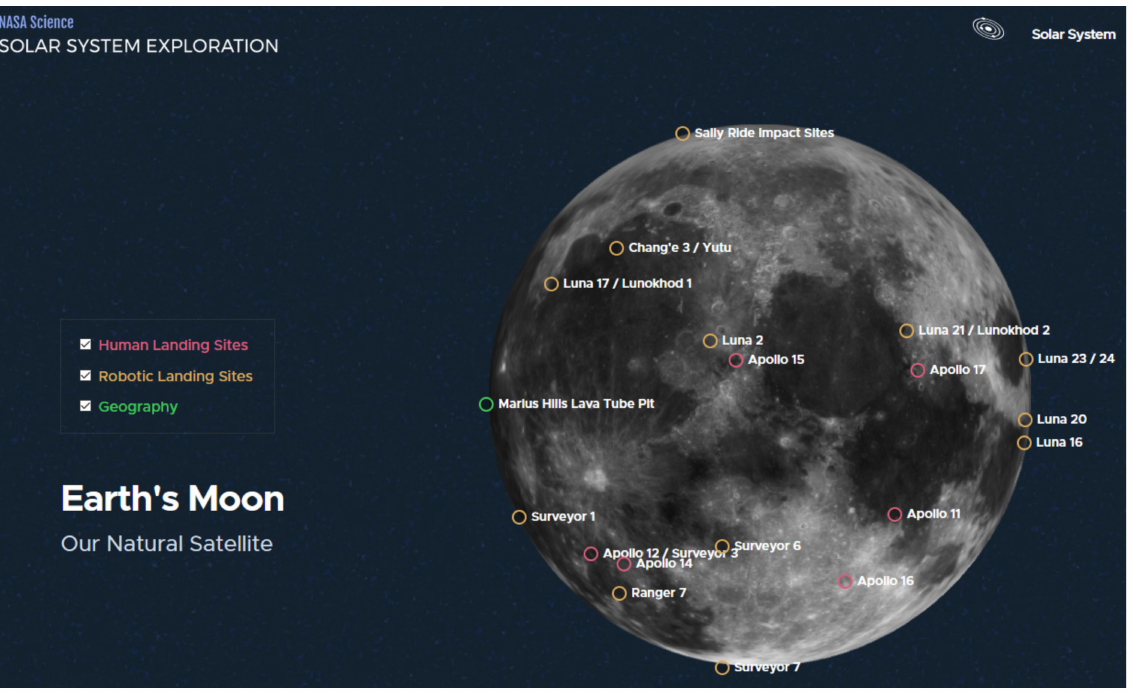
Figure 1. Moon seen from the Earth’s side with the landing sites of manned and non-manned missions marked (there was no landing on the other, so-called dark side); screenshot from NASA interactive map